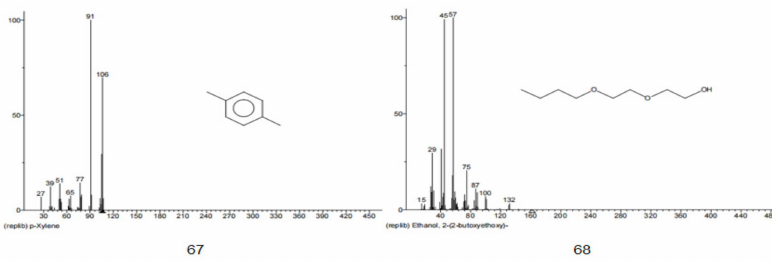
Figure A1. EI-MS fragments of defatted tiger nut flour.